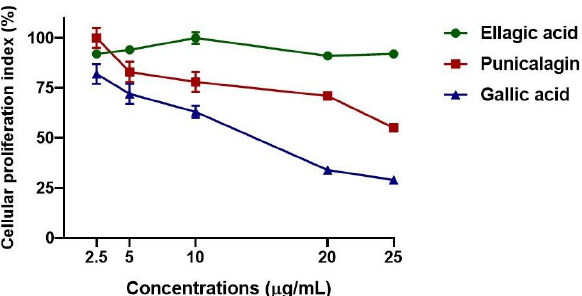
Figure 8. Cytotoxicity assay. Vero cells were treated with different concentrations of punicalagin, ellagic acid, and gallic acid (25 µg/mL, 20 µg/mL, 10 µg/mL, 5 µg/mL and 2.5 µg/mL). The cells were collected 72 h post-treatment, and the cell viability was carried out as described in the Materials and Methods section. The results are shown graphically as the proliferation index (%). The results presented are the means of triplicates ± SD.